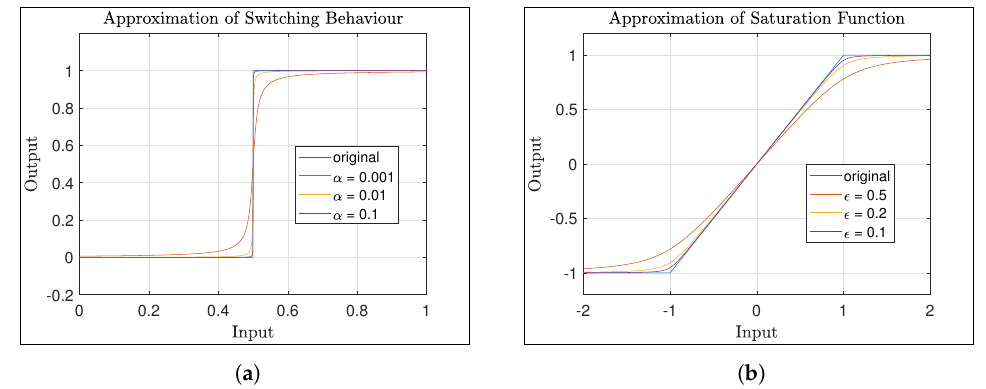
Figure 3. Approximation of model discontinuities with smooth functions for different values of their respective tuning factors. ( a ) Approximation of hard switching function (if/else). ( b ) Approximation of the saturation